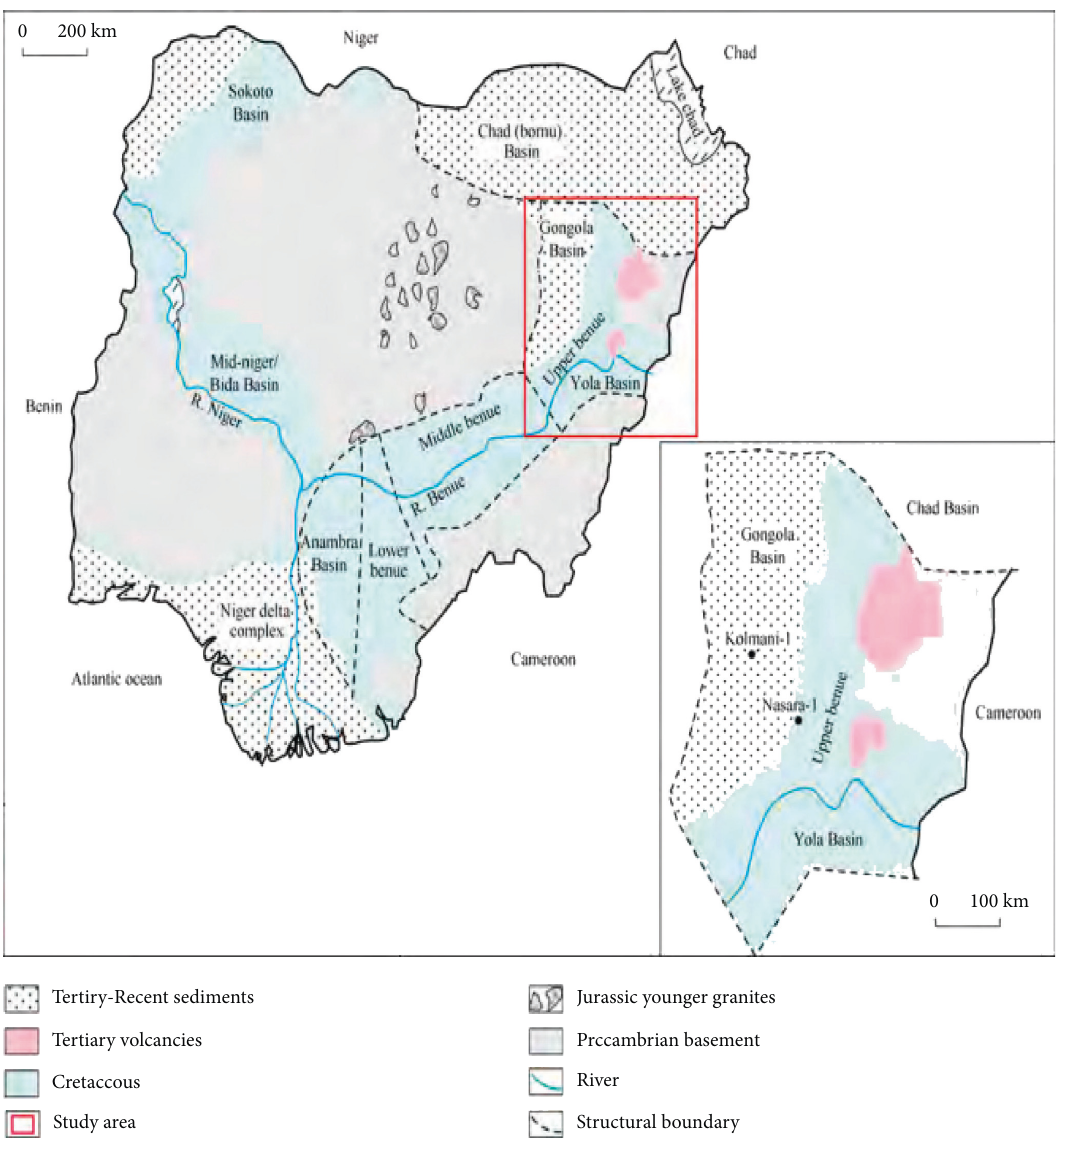
Figure 1: Study area showing geological